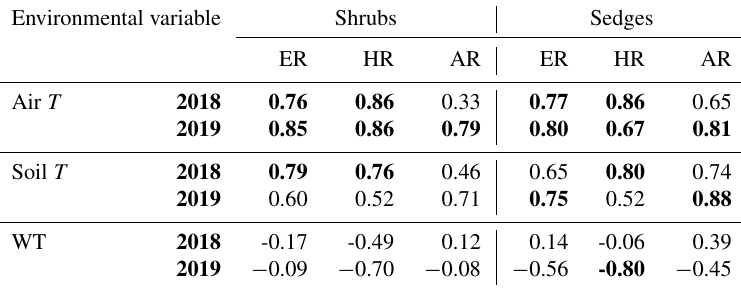
Table A1. Correlation coefficients for relationships between respiration (ER, AR, and HR) and environmental variables in 2018 and 2019. WT is water table depth, air T is air temperature measured at the flux tower, and soil T is soil temperature at 10cm